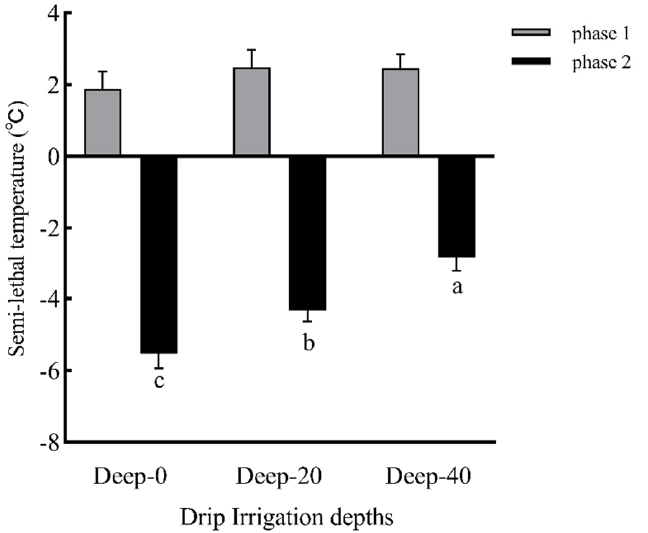
Figure 7. Semi-lethal temperature of alfalfa crowns under three drip irrigation depths at the Figure 7. Semi ‐ lethal temperature of alfalfa crowns under three drip irrigation depths at the phase phase 1 and 2 sampling time points. Lower-case letters above bars indicate a significant differ- 1 and 2 sampling time points. Lower ‐ case letters above bars indicate a significant difference ( p < ence ( p < 0.05, LSD test). 0.05, LSD test).